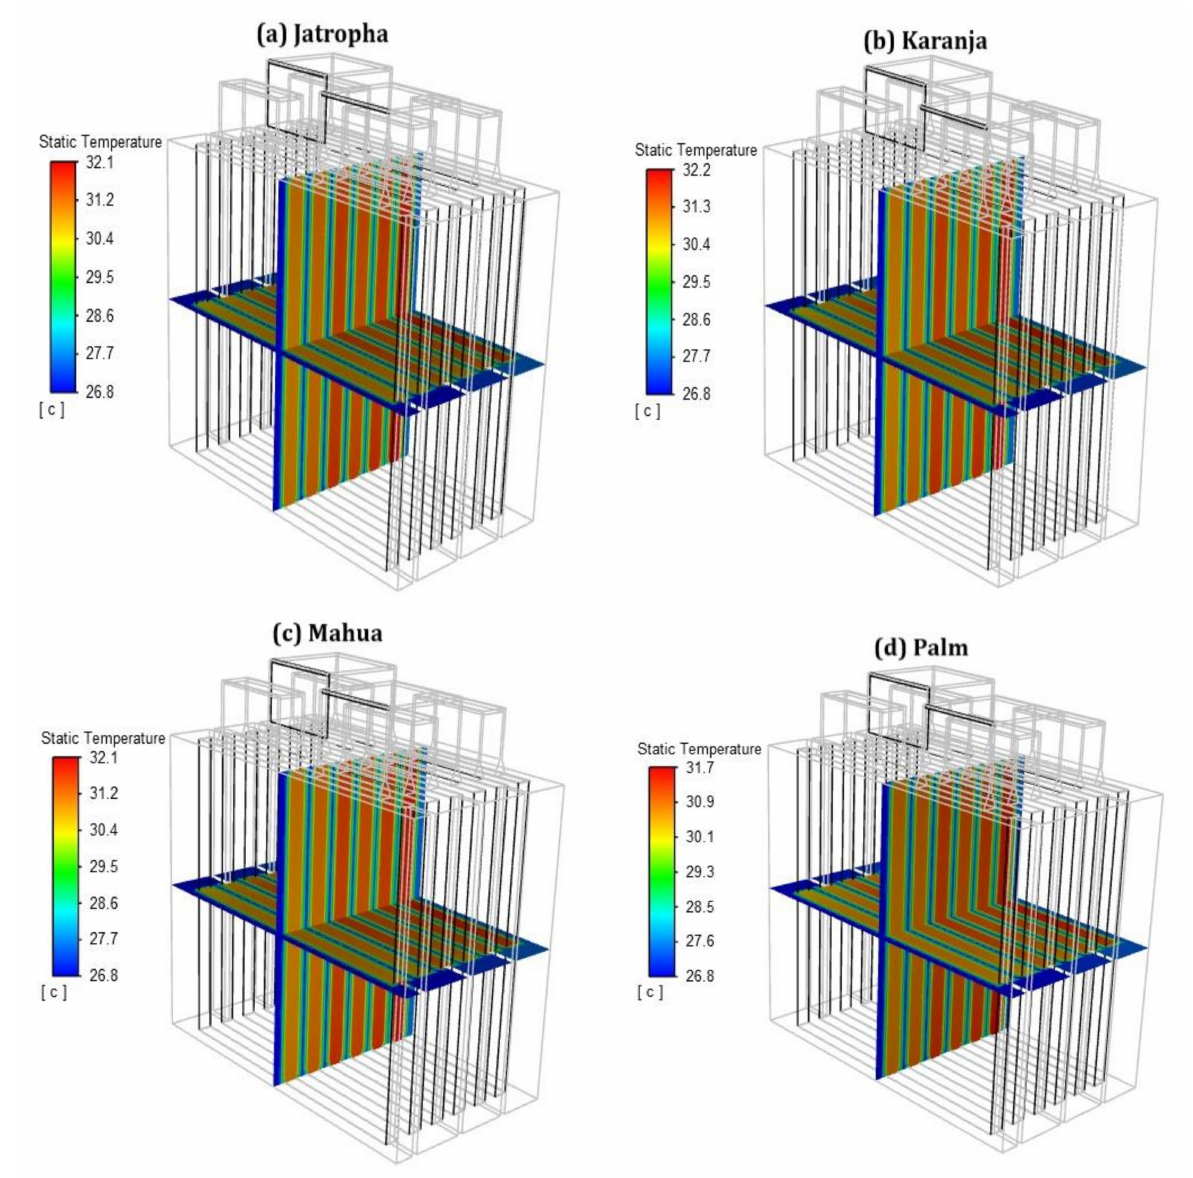
Figure 13. LIB cell cross-sectional temperatures at 3C discharge rates, using the biodiesel oils